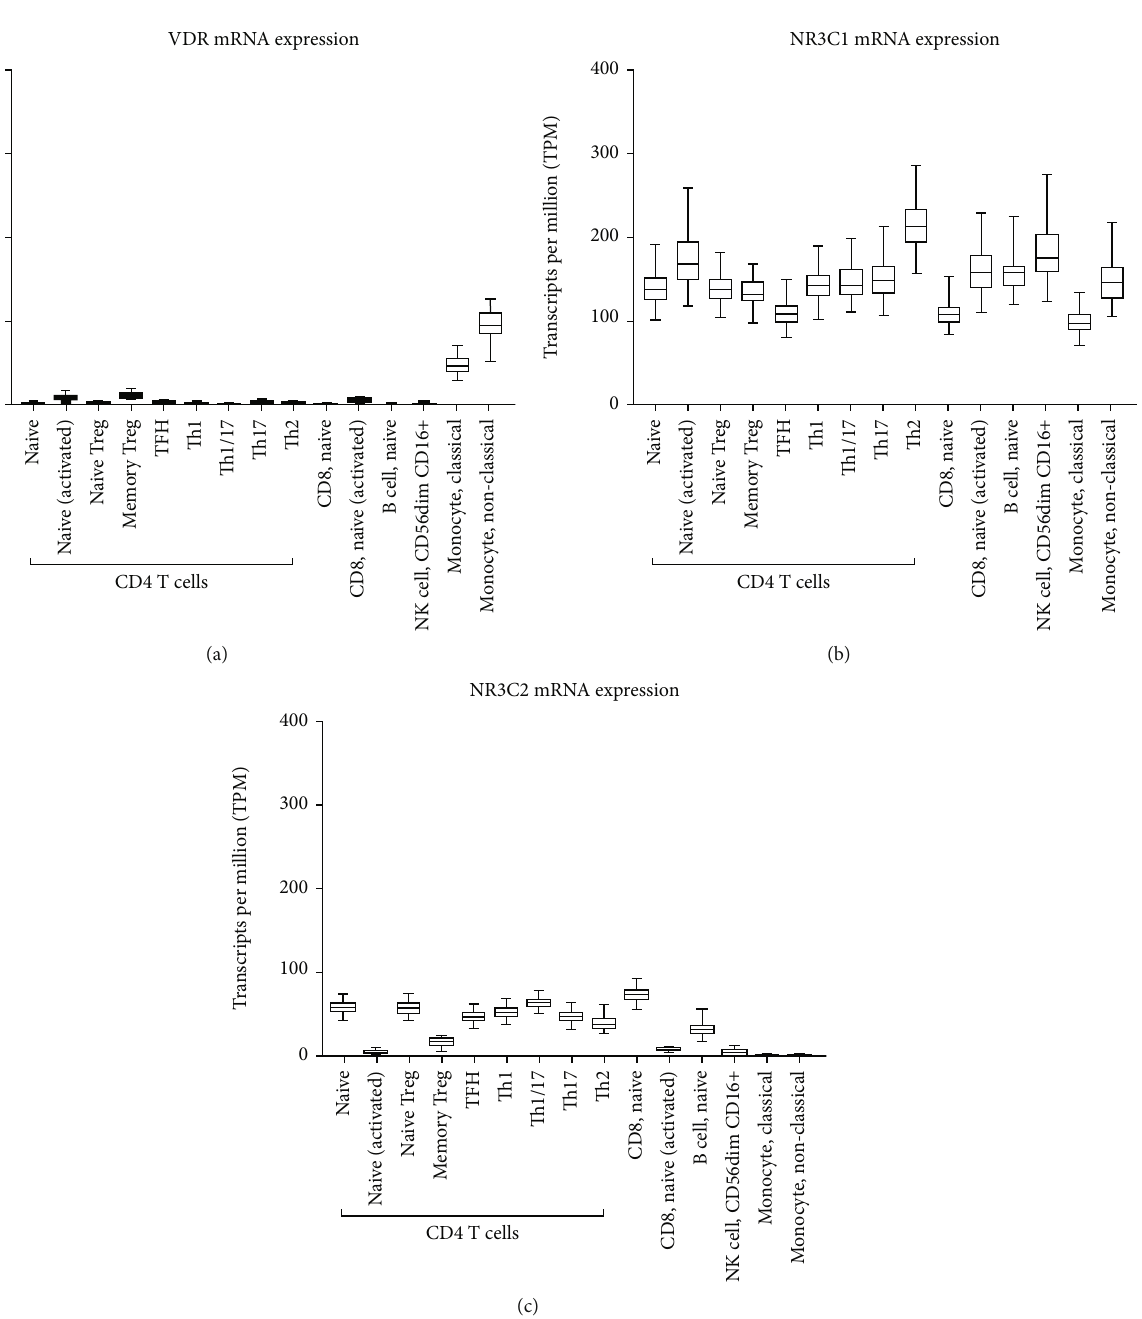
Figure 1: VDR, NR3C1, and NR3C2 mRNA expression levels in immune cells. Data was extracted using the publicly available “ Database of Immune Cell Expression, Expression quantitative trait loci (eQTLs) and Epigenomics.